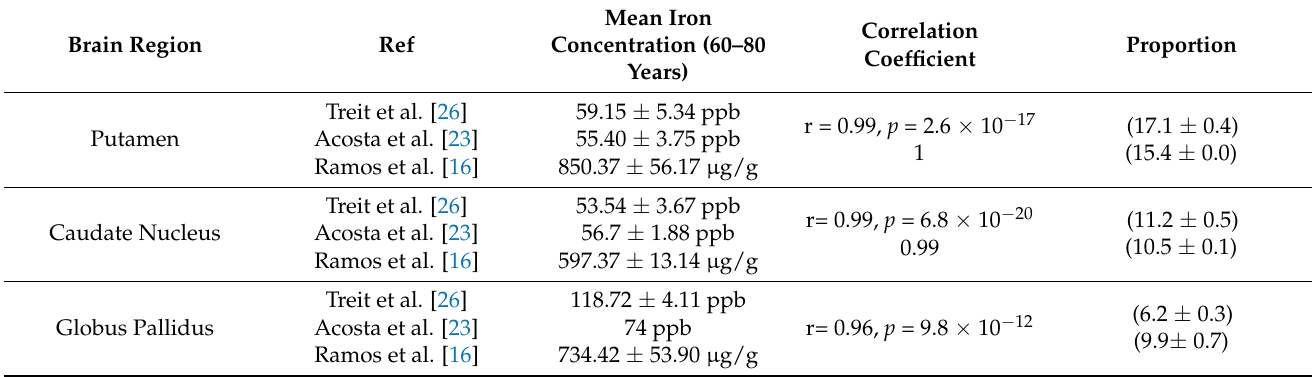
Table 1. Mean iron concentration estimated from QSM and post-mortem analyses in putamen, caudate nucleus, and globus pallidus in the three considered papers. The correlation coefficient (Pearson, r) was calculated between susceptibility and values obtained from post-mortem analysis. The proportion was calculated by dividing post-mortem values by QSM